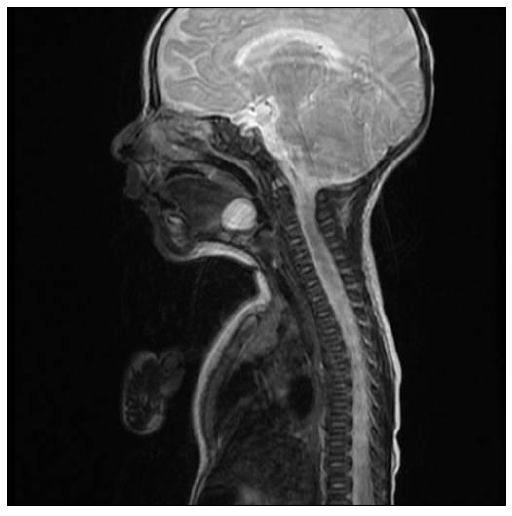
Figure 3: MRI Showing Cyst Bleeding points were coagulated using the same wand. The child was attached to the ventilator immediately and was taken off on a postoperative day 1. The tracheostomy tube was closed on day 2